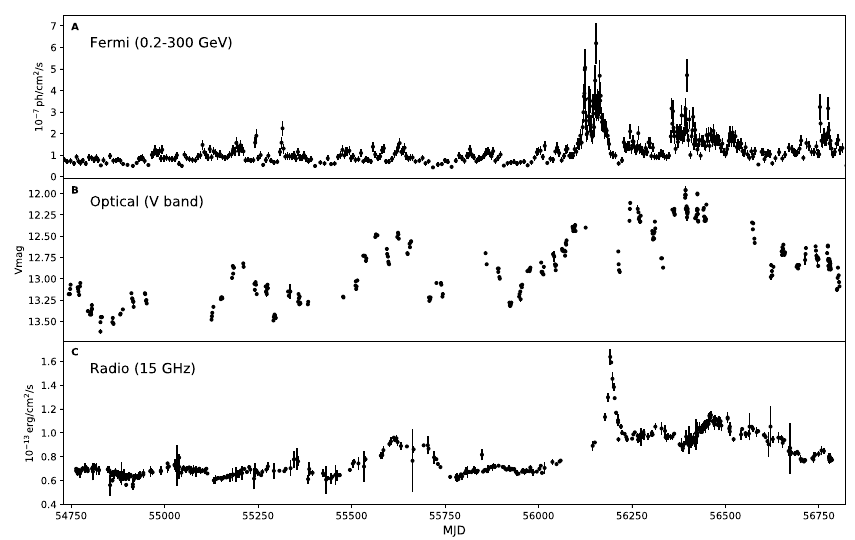
Figure 1. The multi-wavelength blazar spectral energy distribution (SED) of Mkn421. The marked VHE gamma-ray points are provided by the Brazilian Science Data Center (BSDC) database. The plot is made collecting data from a dozen catalogues spanning more than 30 years, collected by over 10 different instruments. They come from a number of catalogues which are integrated and made available online via Italian Space Agency (ASI) Science Data Center (ASDC).The plots are produced with SEDBuilder [10].